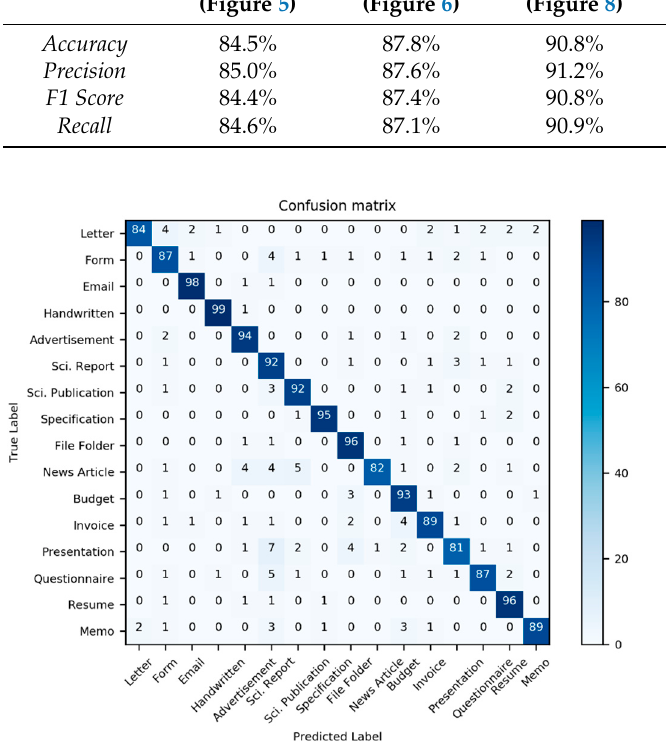
Figure 12. Confusion matrix of the performance results of model III for 1600 test data from the dataset Haley et al. [59]. (Source: our own images).